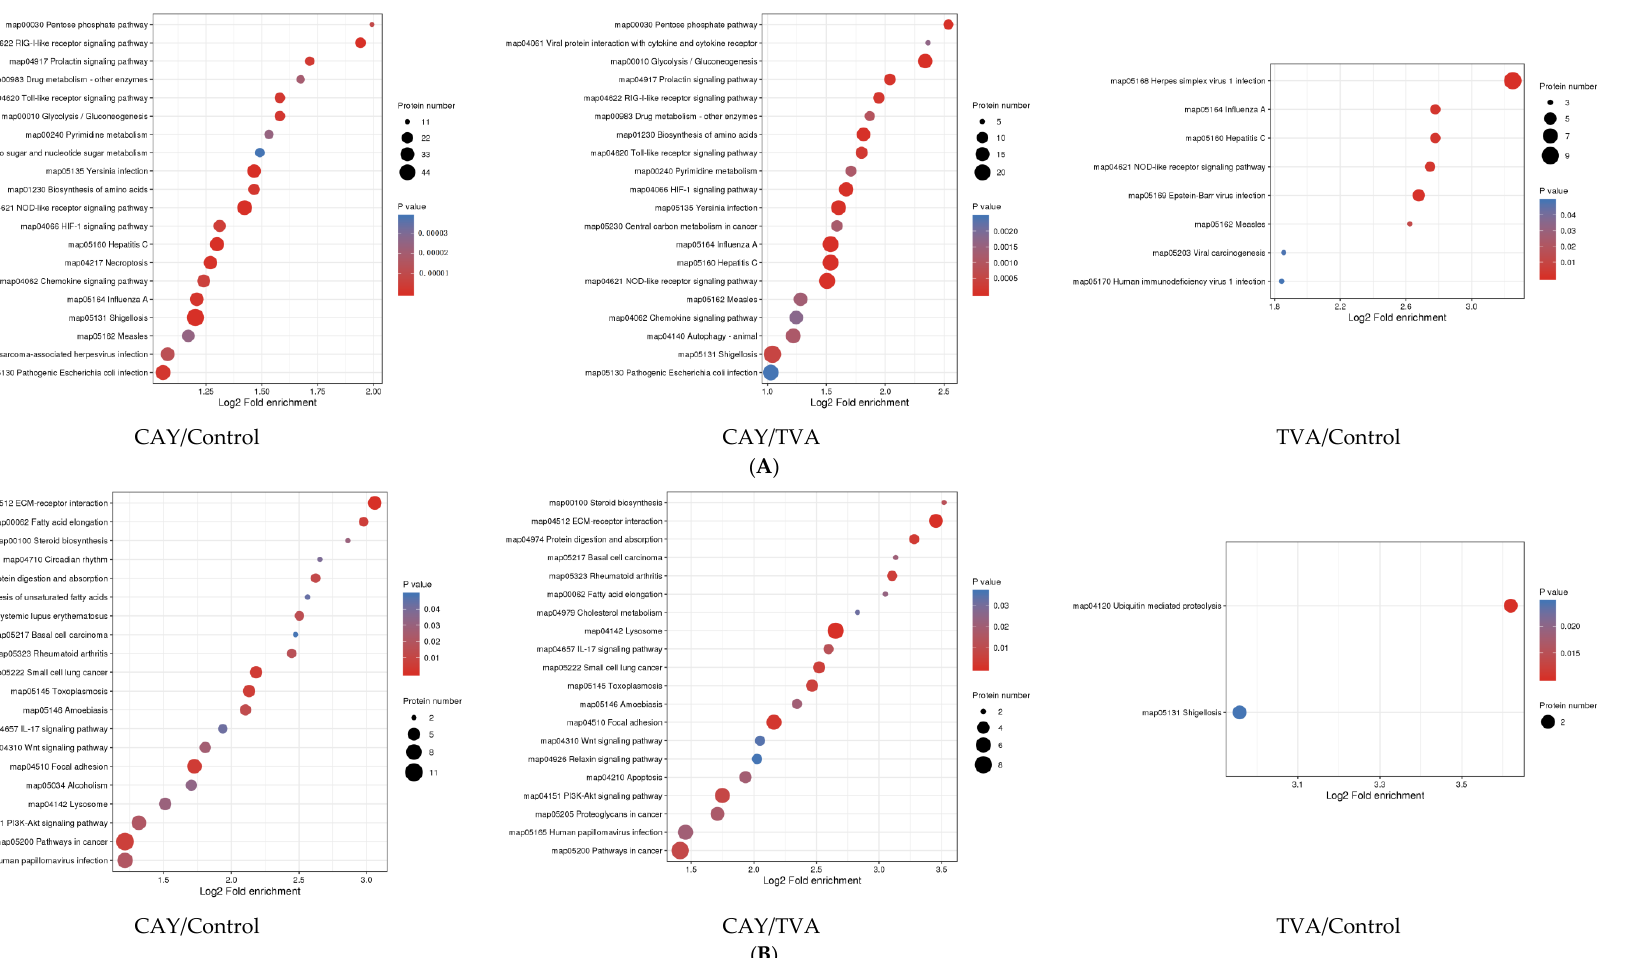
Figure 6. KEGG enrichment pathway map of the up-regulated proteins ( A ) and down-regulated proteins ( B ) in MAC-T cells under different incubation conditions. CAY group (SCD1-inhibited MAC- T cells model): incubated with 50 μM TVA for 2.5 h after the treatment of CAY10566 at concentrations of 10 nM for 12 h, TVA group: only incubated with 50 μM TVA for 2.5 h, and control group: without CAY, TVA.